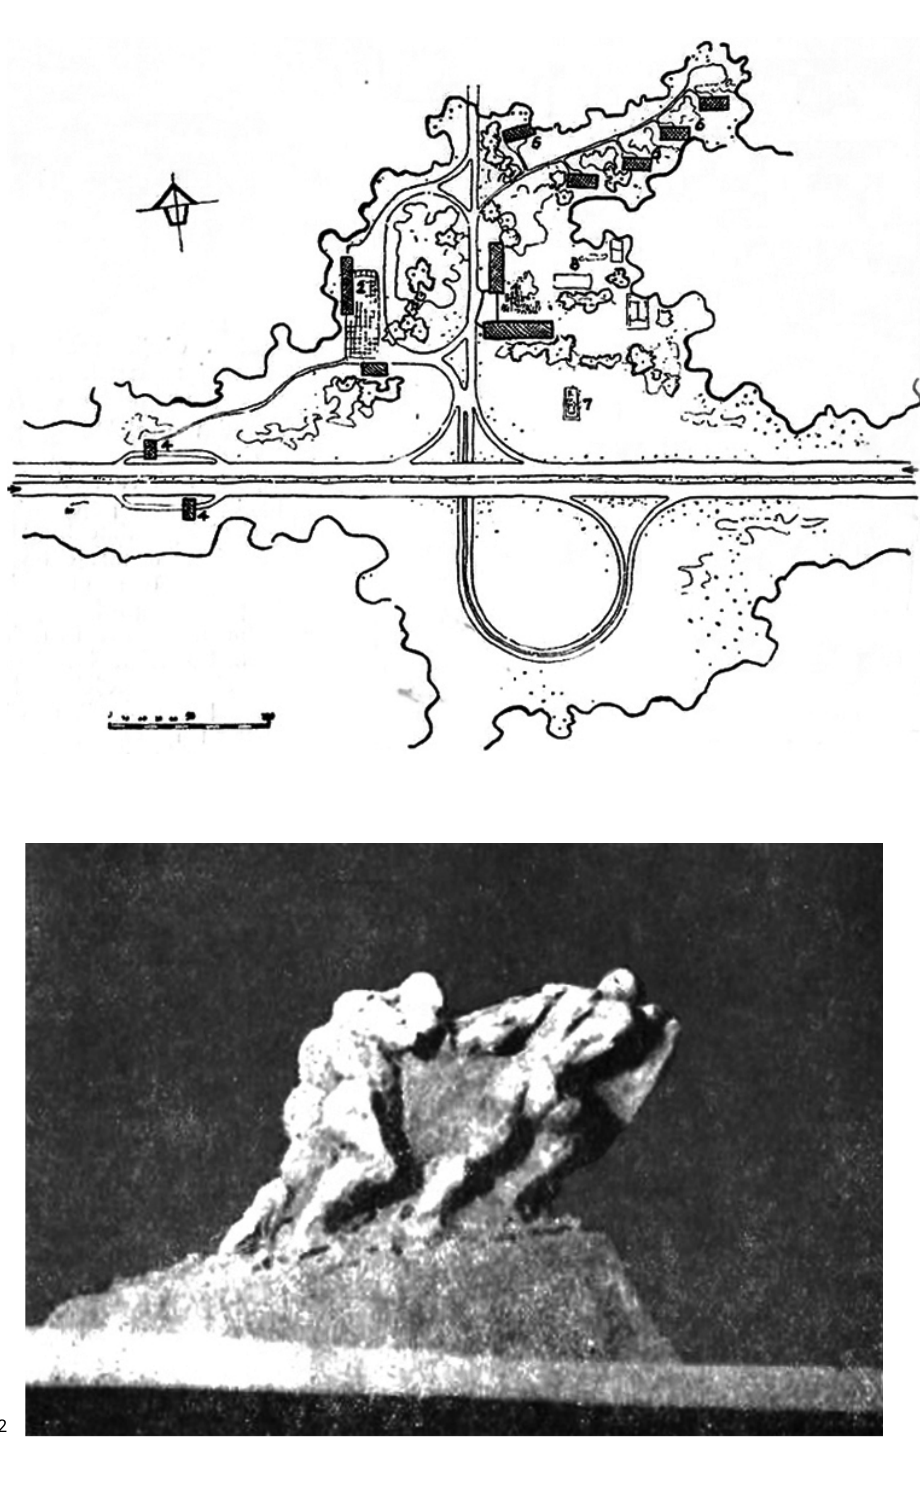
Project entry by Fedor Wenzler and other students for a stag- ingpost along the Highway of Brotherhood and Unity. On the top the scheme which includes the main pavilion with restau- rant and hotel, a car-service, a police station and a cluster of bungalows in the sheltering woodland. The bottom picture shows a maquette for the monumental sculpture representing youth workers building the